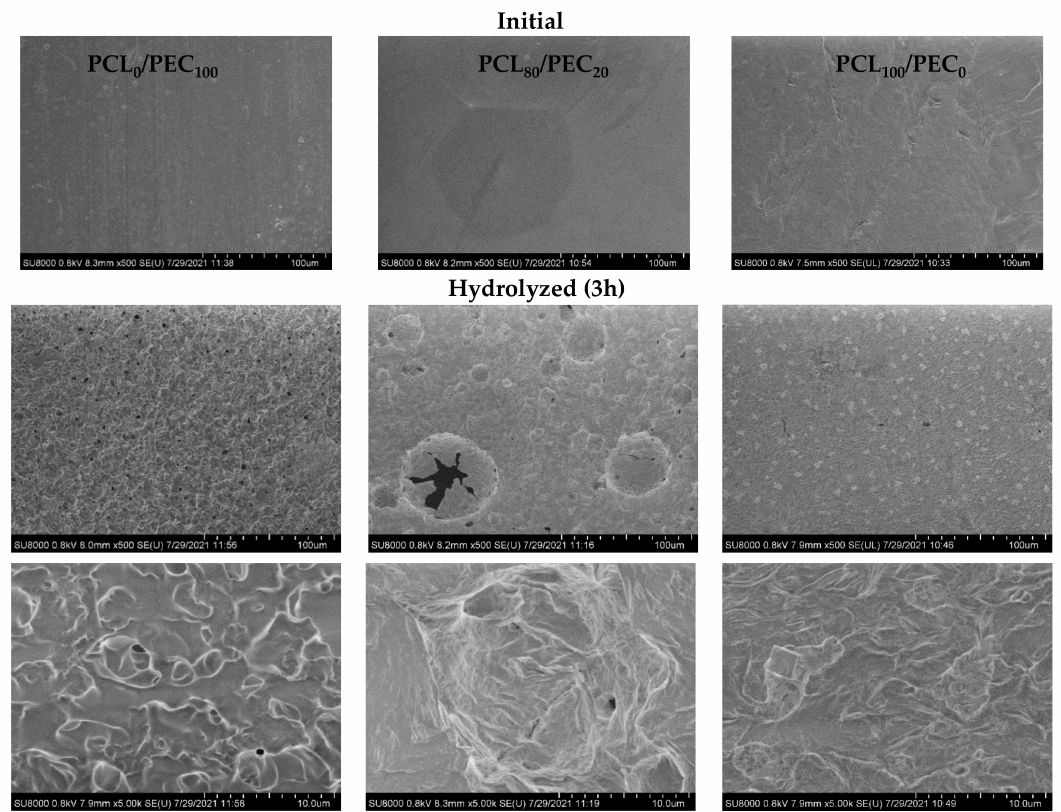
Figure 6. SEM micrographs of initial and hydrolyzed membranes after 3